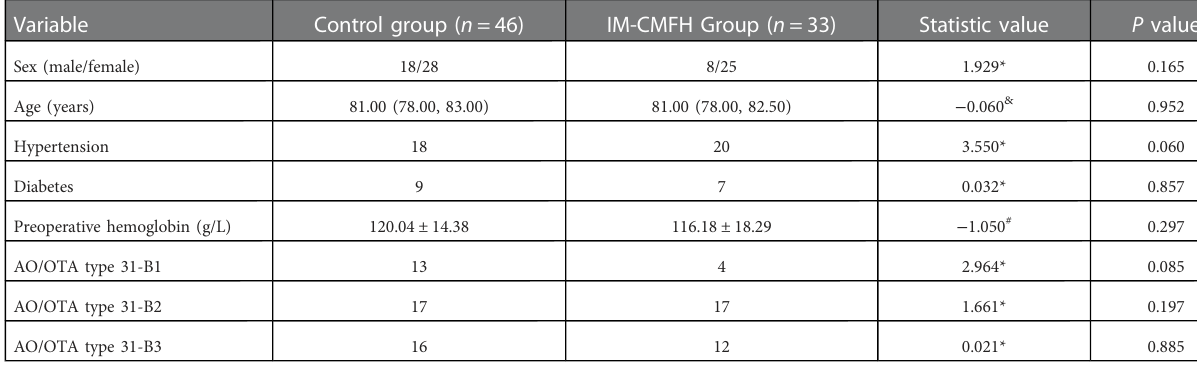
TABLE 1 Demographic characteristics of all